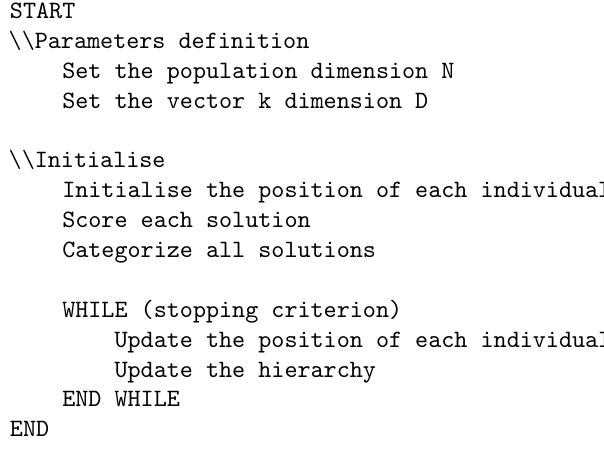
Figure 5. Pseudo-code for GWO algorithm, as taken from